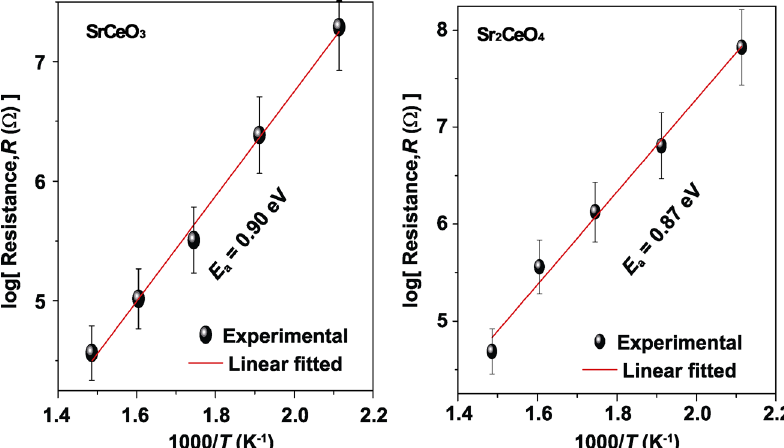
Fig. 8 Variation of logarithm of R with inverse of